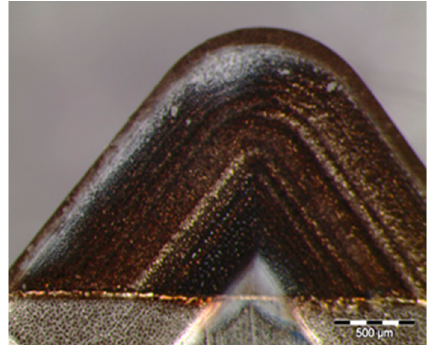
Figure 9. Ablated chip breaker in the polycrystalline diamond (PCD) insert.